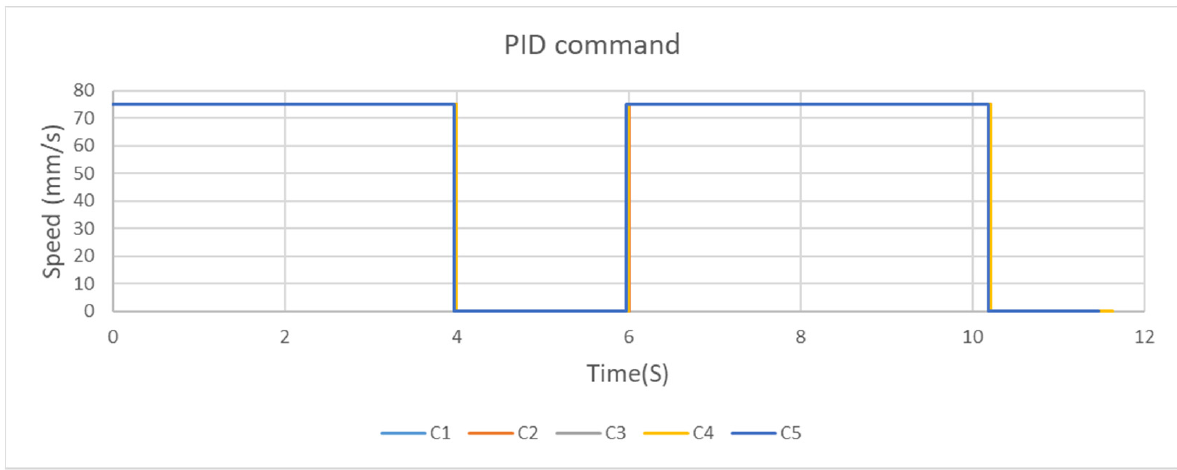
Figure 13. Event-based control speed output in the maximum speed case.